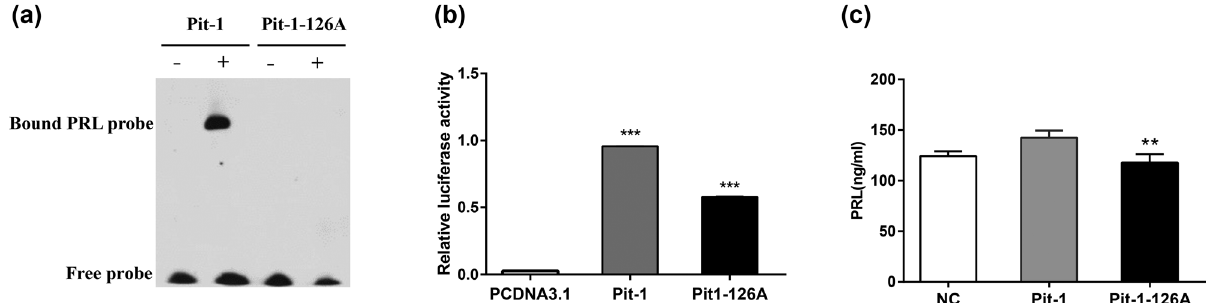
Figure 3: WT - Pit - 1 promotes PRL secretion and induces PRL expression. ( a ) Pit - 1 - PRL complexes were detected. ( b ) Ser126A - Pit - 1 signi fi - cantly inhibited the luciferase activity of the PRL 3 ′ UTR relative to the levels seen with Pit - 1. ( c ) The PRL level of the Pit - 1 groups was higher than that of the Pit - 1 - 126A groups. **, P < 0.01; ***, P < 0.001. The bar represents the mean ± SD.